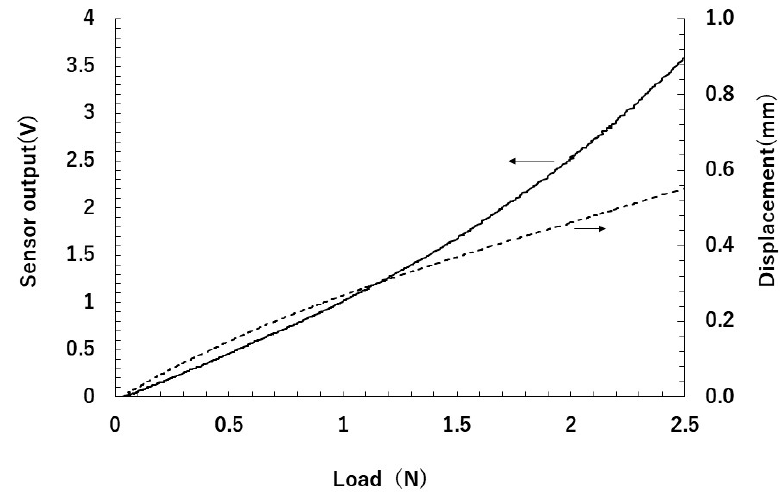
Figure 8. Results of constant-speed loading test (at 0.5 mm/min). A standard test weight was placed on the convex part of the sensor and the sensor output was measured. Figure 9 shows the results of 10 measurements using the same weight. The averages of the 10 measurements are indicated by open circles, and the maximum and minimum values are indicated by horizonal bars.